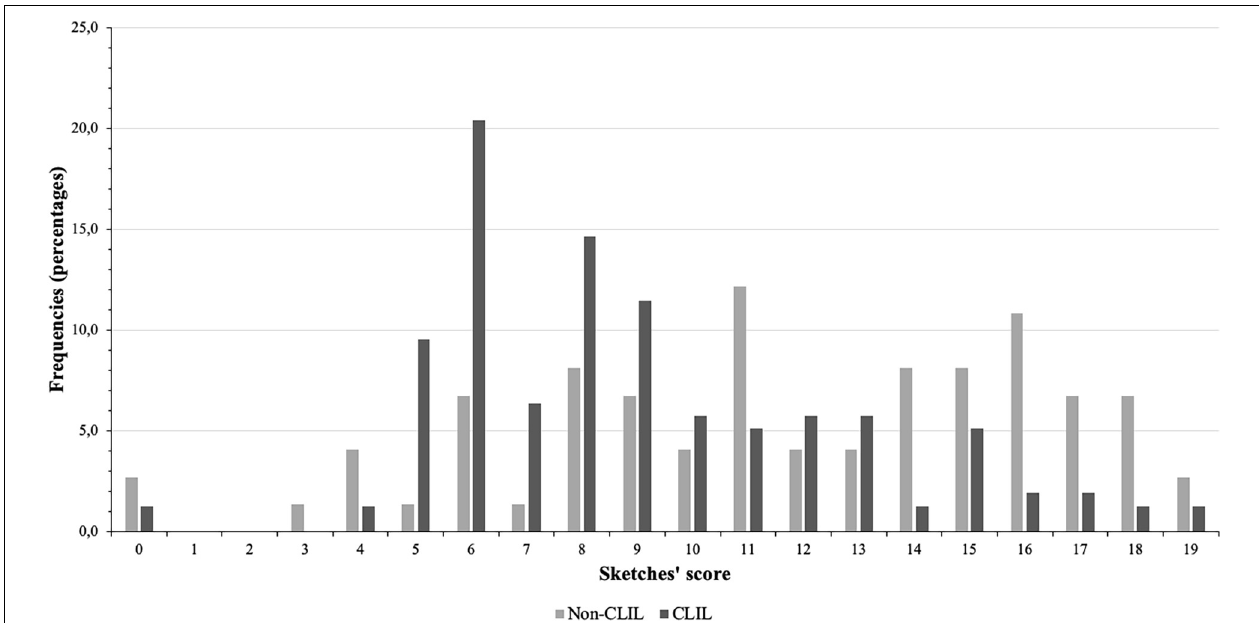
FIGURE 4 | Category frequencies after analyses of students’ responses to the open questions for both non-CLIL and CLIL learners.